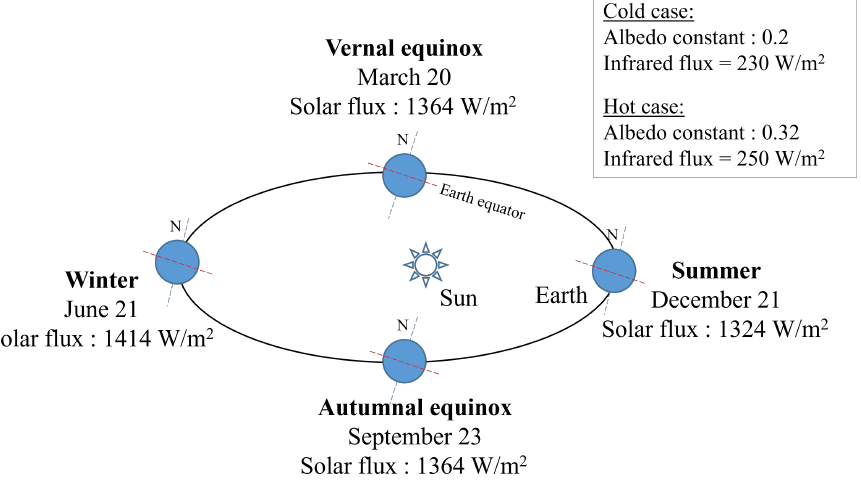
Figure 11. Variation in environmental heat loads due to Earth’s